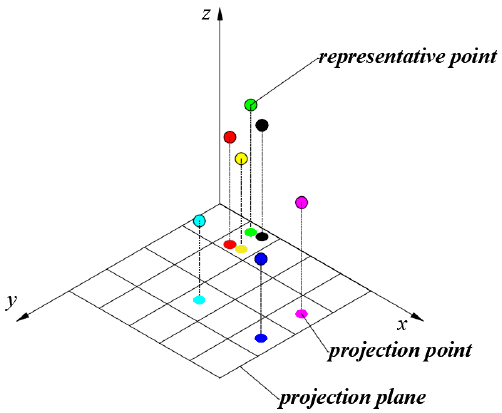
Figure 5. Crop region surface point cloud screening principle schematic.